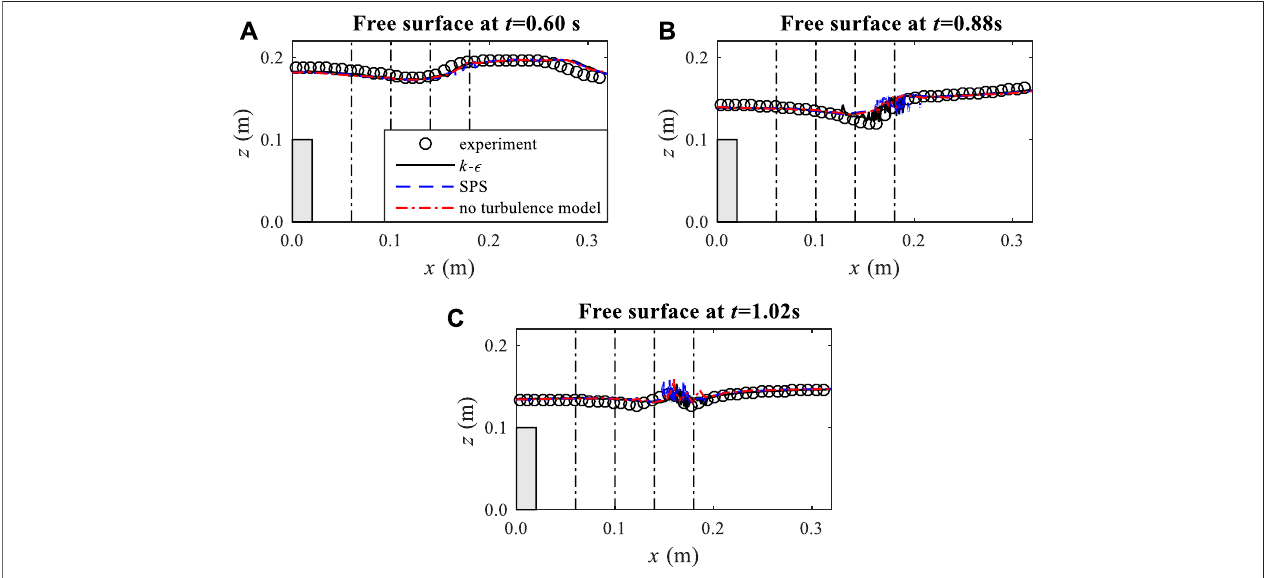
FIGURE 3 | Comparisons between experimental data and numerical results for the free surface elevations at three times t (cid:2) (A) 0.60 s; (B) 0.88 s; and (C) 1.02 s.